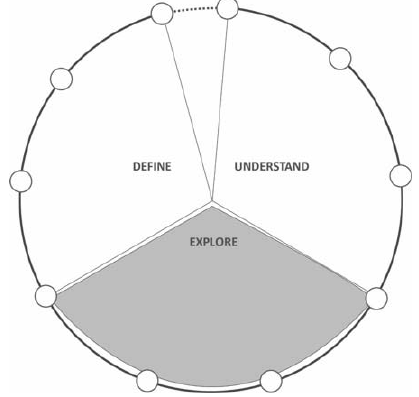
Figure 5. PSS design process phase: Explore.